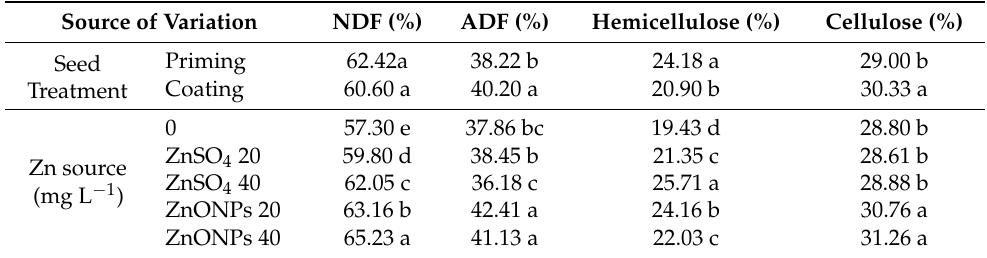
Table 5. Effect of time duration (DAS) and seed treatment with various concentrations of ZnONPs applied on fiber content in fodder maize crop (variety J-1006) grown under field conditions.